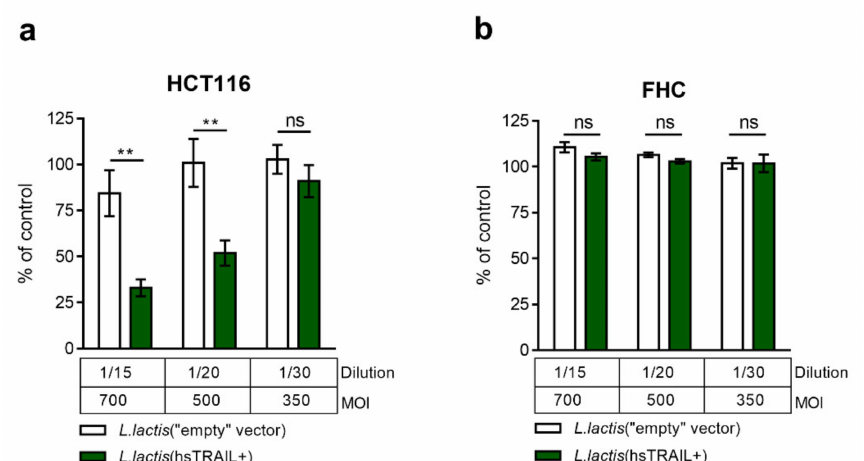
Figure 1. Selective cytotoxicity of L. lactis (hsTRAIL+)-derived hsTRAIL against colon cancer cells in a direct co-culture model of human cell lines with bacteria. Human HCT116 CRC cells ( a ) and normal epithelial colon cells (FHC) ( b ) were cultured for 48 h in the presence of L. lactis (hsTRAIL+) or corresponding control bacteria ( L. lactis (“empty” vector)) with addition of nisin (inducer). Viability of cancer and non-malignant cells was assessed by MTS test. Results are showed as % of viability of cells incubated in an appropriate standard culture medium ( y -axis) without bacteria. Legend: Multiplicity of Infection—MOI—is the number of bacteria per single eukaryotic cell; 1/15–1/30—dilution of L. lactis (hsTRAIL+)/ L. lactis (“empty” vector) broth culture. The bars indicate the mean value ± SEM of three independent experiments, each performed in triplicates ( n = 3). Statistical significance was calculated using two-way ANOVA test, with Tukey’s multiple comparisons post-hoc test. ** p <